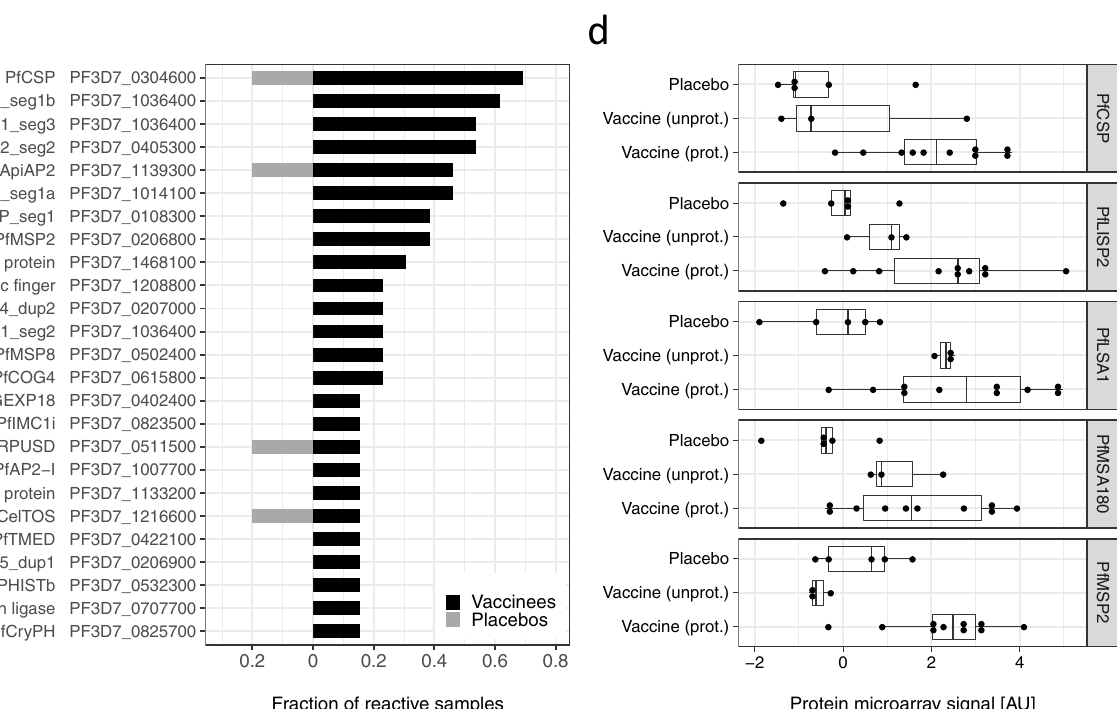
Fig. 7 IgG antibody reactivity against Plasmodium falciparum antigens. a IgG antibody levels speci fi c for PfCSP were measured by ELISA using sera from volunteers before the fi rst immunization (D-1), 15 days after the last immunization (D 44), as well as 1 day before CHMI (C-1). PfCSP-speci fi c